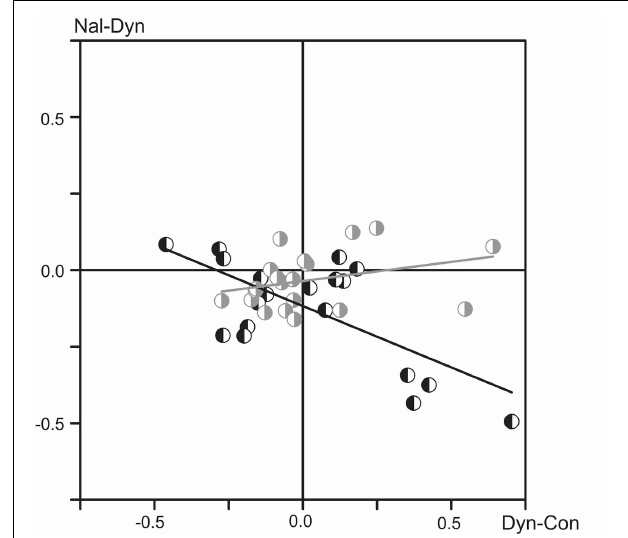
FIGURE 4 | Analysis of interdependence between the normalized mean values of the FP changes that have been evoked by the injected substances (all tests recorded in nine experiments). The data for the left and right sides of the spinal cord are presented separately using the left- or right-hand shadowed symbols in black and gray colors, respectively. The linear regression lines (marked by the corresponding colors) are defined for the two data sets separately, and their parameters are as follows: r = − 0 . 68; S (slope) = − 0 . 40 (left side); r = 0 . 31; S = 0.12 (right